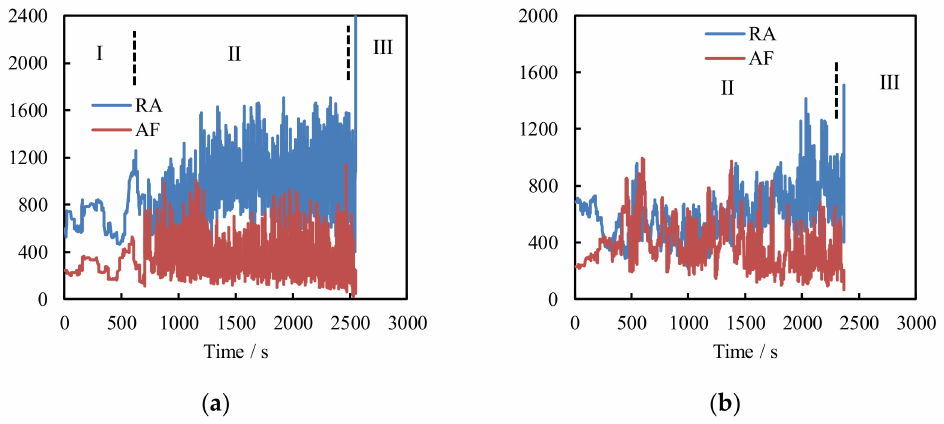
Figure 13. AE parameters RA and AF: ( a ) BFRPC beam; ( b ) BFRPC-N